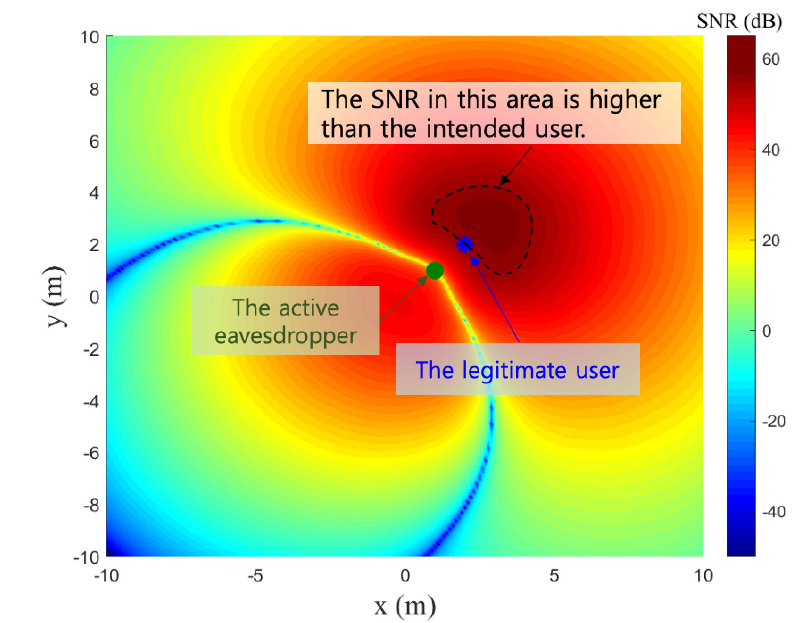
Figure 1. SNR according to receiver locations when zero-forcing (ZF) precoding is utilized. The 10 × 10 transmitter array consists of LEDs that are uniformly distributed on a square lattice in a room of 20 × 20 m 2